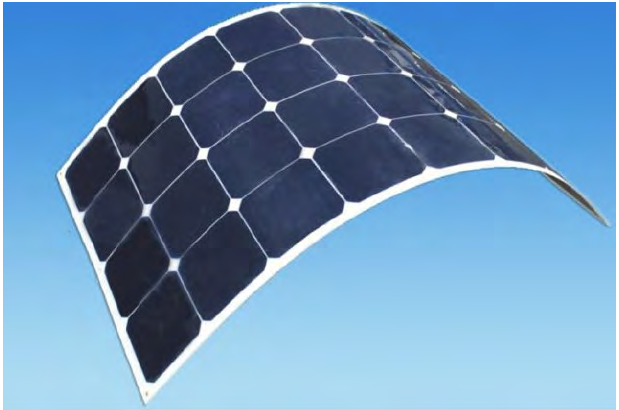
Figure 11. Flexible PV cells (nbamyjo.com)